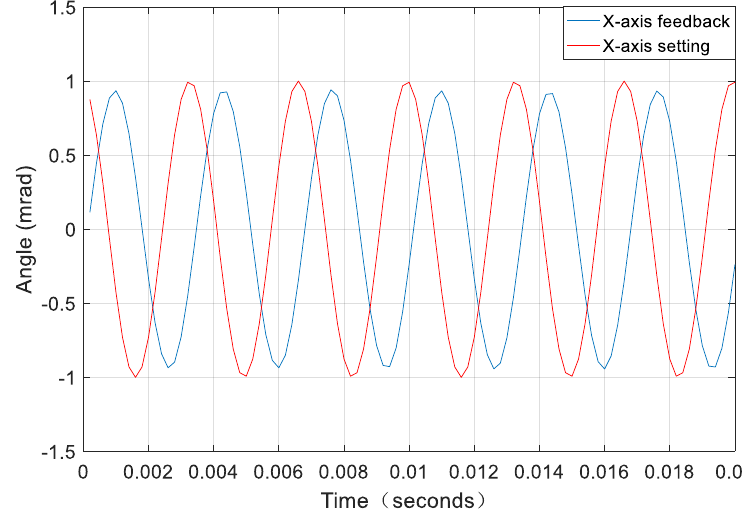
Figure 11. X-axis antidisturbance capability test.